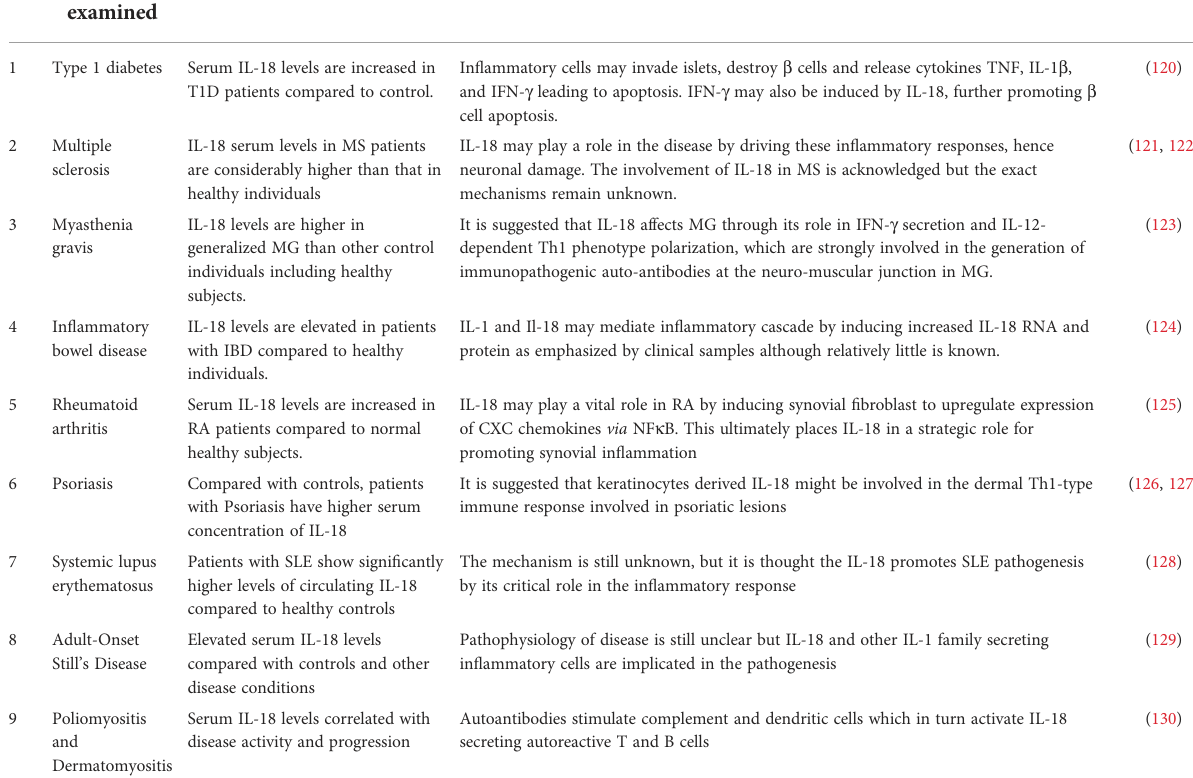
TABLE 1 Immunopathogenic mechanism of interleukin 18 involvement in autoimmune